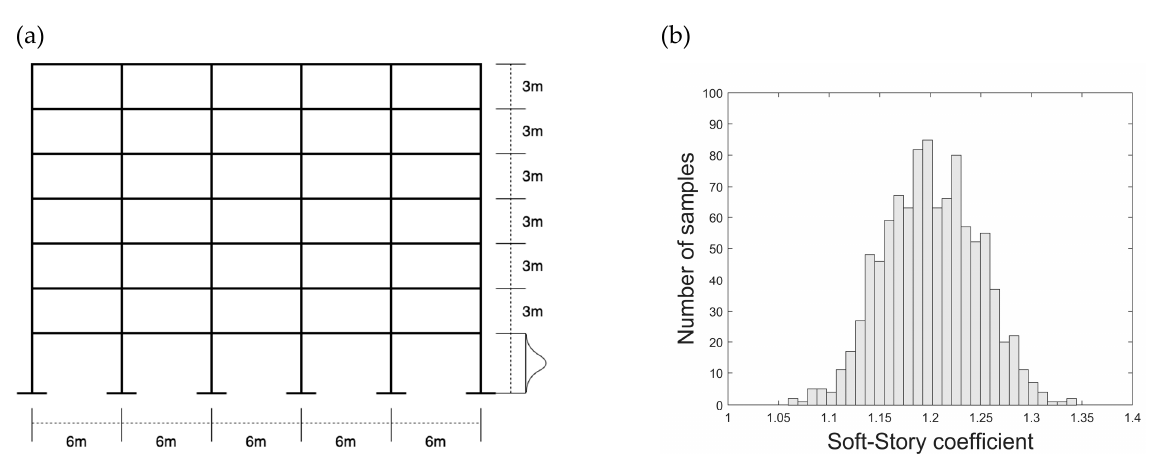
Figure 1. ( a ) Seven-story building 2-D models to perform the statistical analysis; ( b ) soft-story coefficient distribution for the first storey.